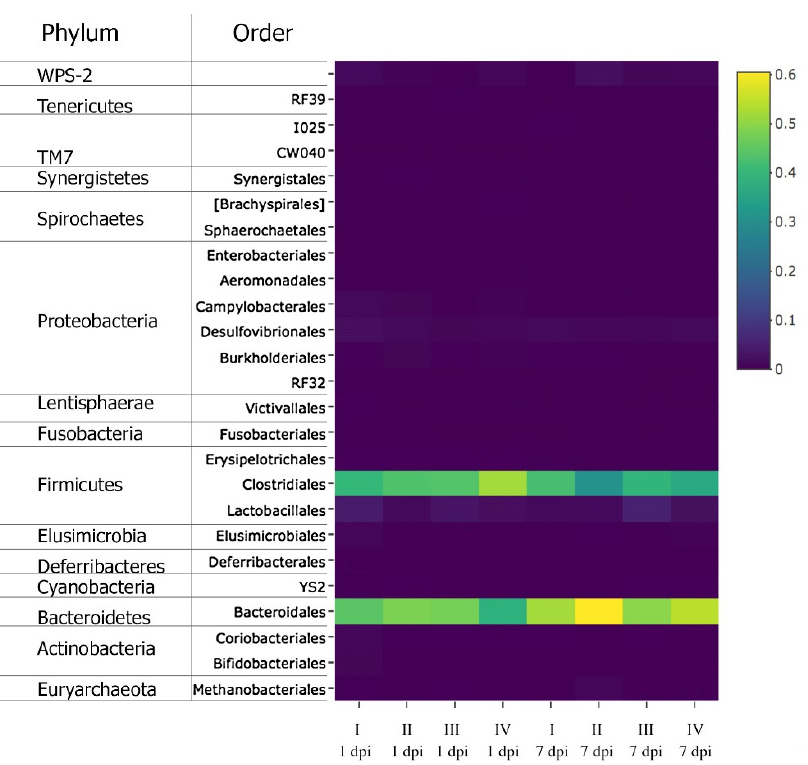
Figure 3. Heat map of the cecal microbiome biodiversity in laying hens at 1 and 7 dpi at the level of orders and higher taxonomic ranks in the subgroups: I (negative control), II (SE challenge), III (Intebio ® intake), and IV (Intebio ® intake + SE challenge). The columns correspond to subgroups and the rows to bacterial taxa. On the color scale, a value of 0.1 is equal to 10% of the representation of microorganisms in the community.